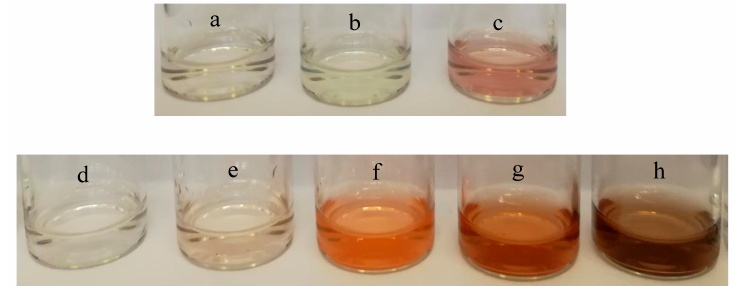
Figure 1. Photographs of detection of ractopamine (RAC; top) by SiW 9 Cu 3 and dopamine (DA; bottom) by SiW 9 Co 3 ; ( a ) RAC + H 2 O 2 + 25 min; ( b ) RAC + SiW 9 Cu 3 + 25 min; ( c ) RAC + SiW 9 Cu 3 + H 2 O 2 + 25 min; ( d ) DA + H 2 O 2 + 10 min; ( e ) DA + SiW 9 Co 3 + 10 min; ( f ) DA + SiW 9 Co 3 + H 2 O 2 + 10 min;